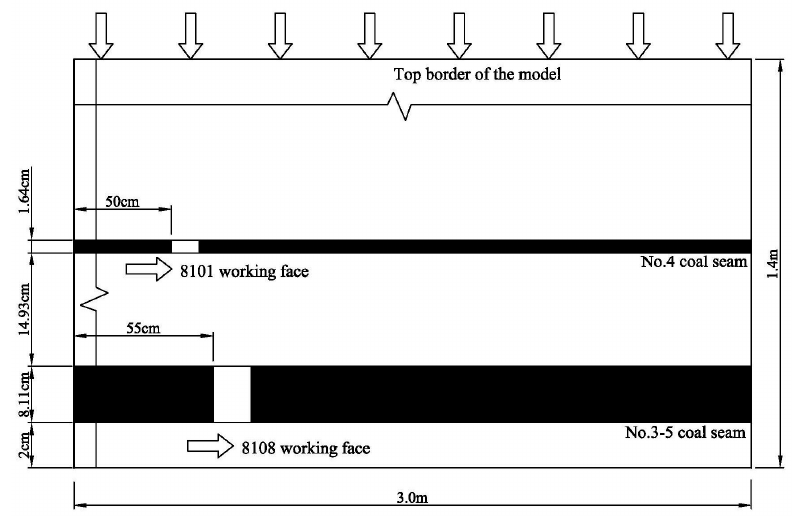
Figure 7. Experimental model scheme.